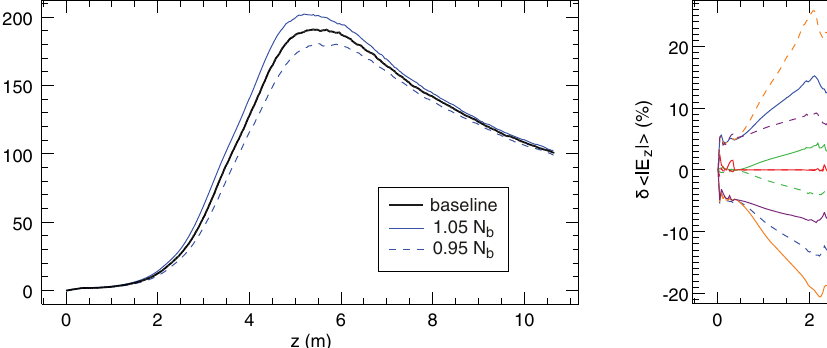
FIG. 1. Average absolute value of E z for 0 < r < k − 1 function of the propagation distance z for the baseline simulation and for the (cid:1) 5% variations in N b .